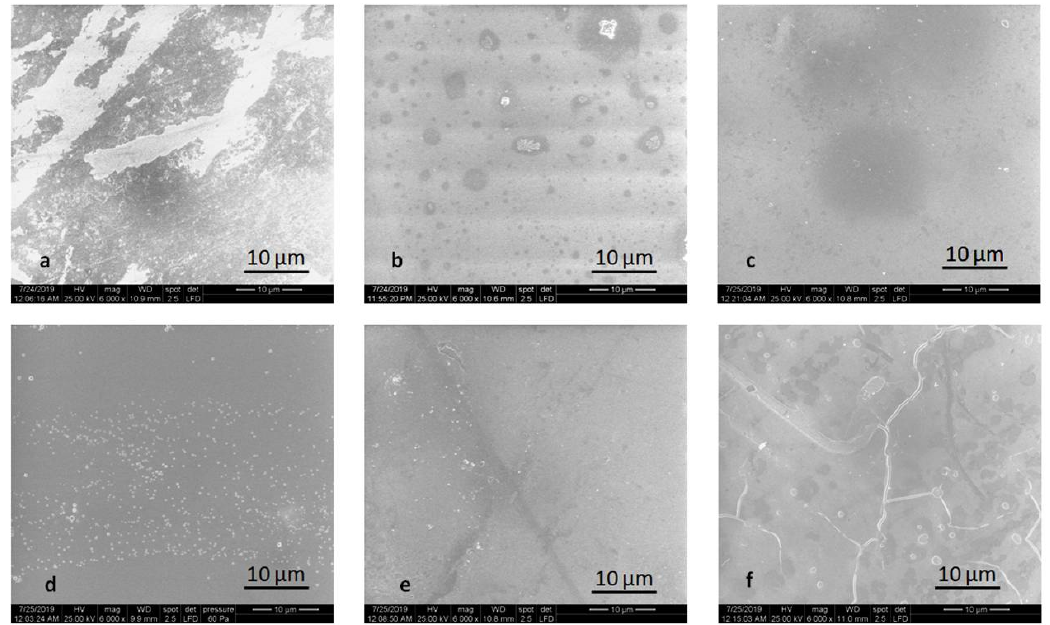
Figure 7. SEM images of the polished samples after thermocycling: ( a ) LDS-P-P-HT, ( b ) LDS-P-P-MT,